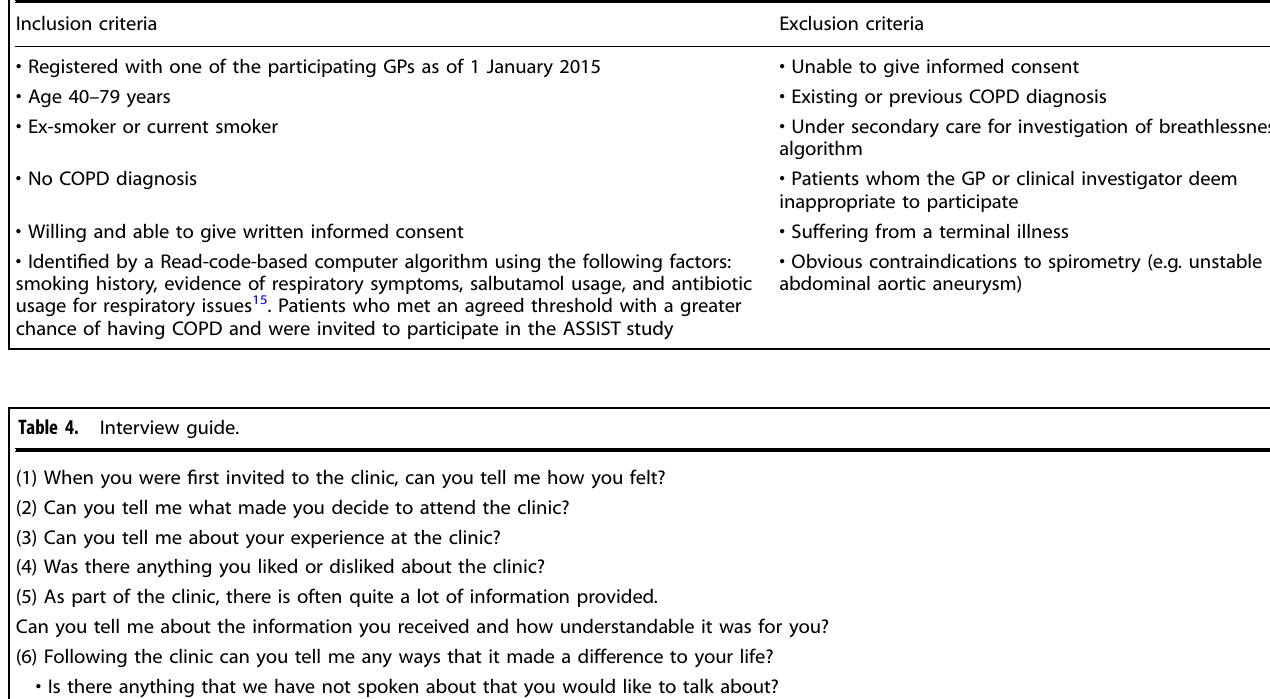
Table 3. Patient eligibility criteria for the ASSIST study.